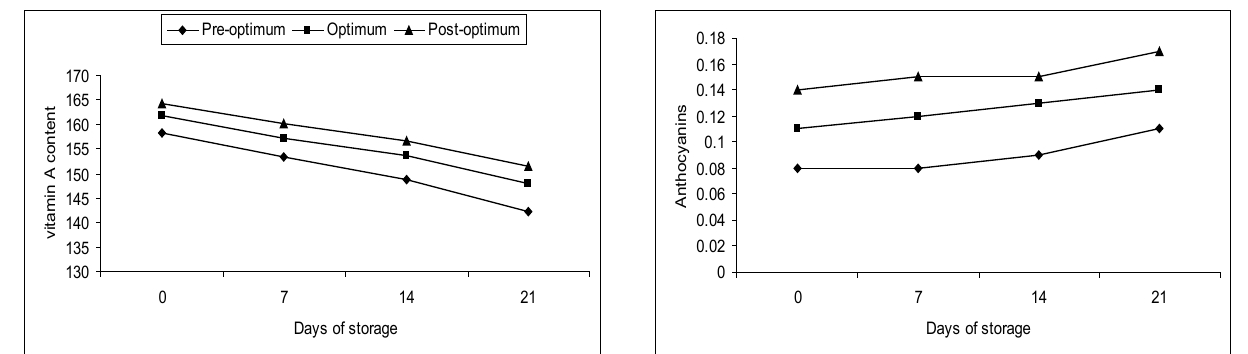
Fig. 2. Effect of harvesting stage on the vitamin A content and anthocyanins content of peach fruits during cold stor- age